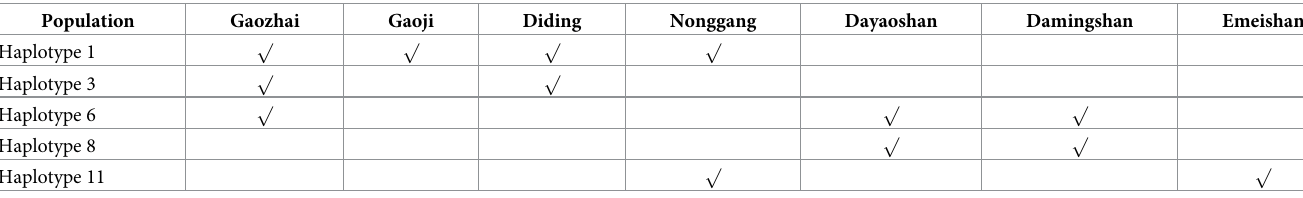
Table 3. Haplotypes of COI sequences shared by populations of T . sinensis .